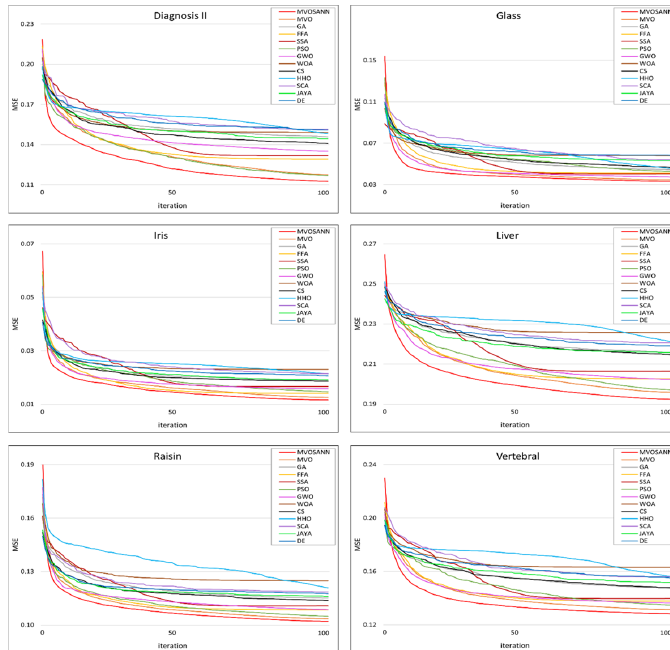
Fig. 8. Convergence curves of Diagnosis II, Glass, Iris, Liver, Raisin, Vertebral